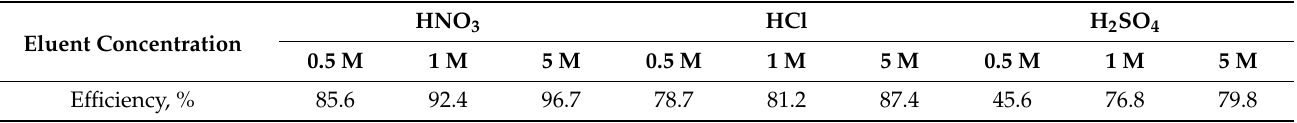
Table 6. Desorption efficiency of Ru(III) using various